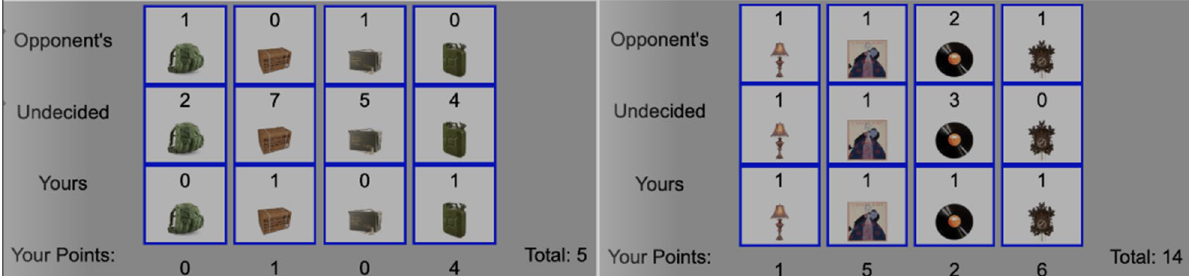
Figure 2. Items negotiated over in the military versus civilian conditions.